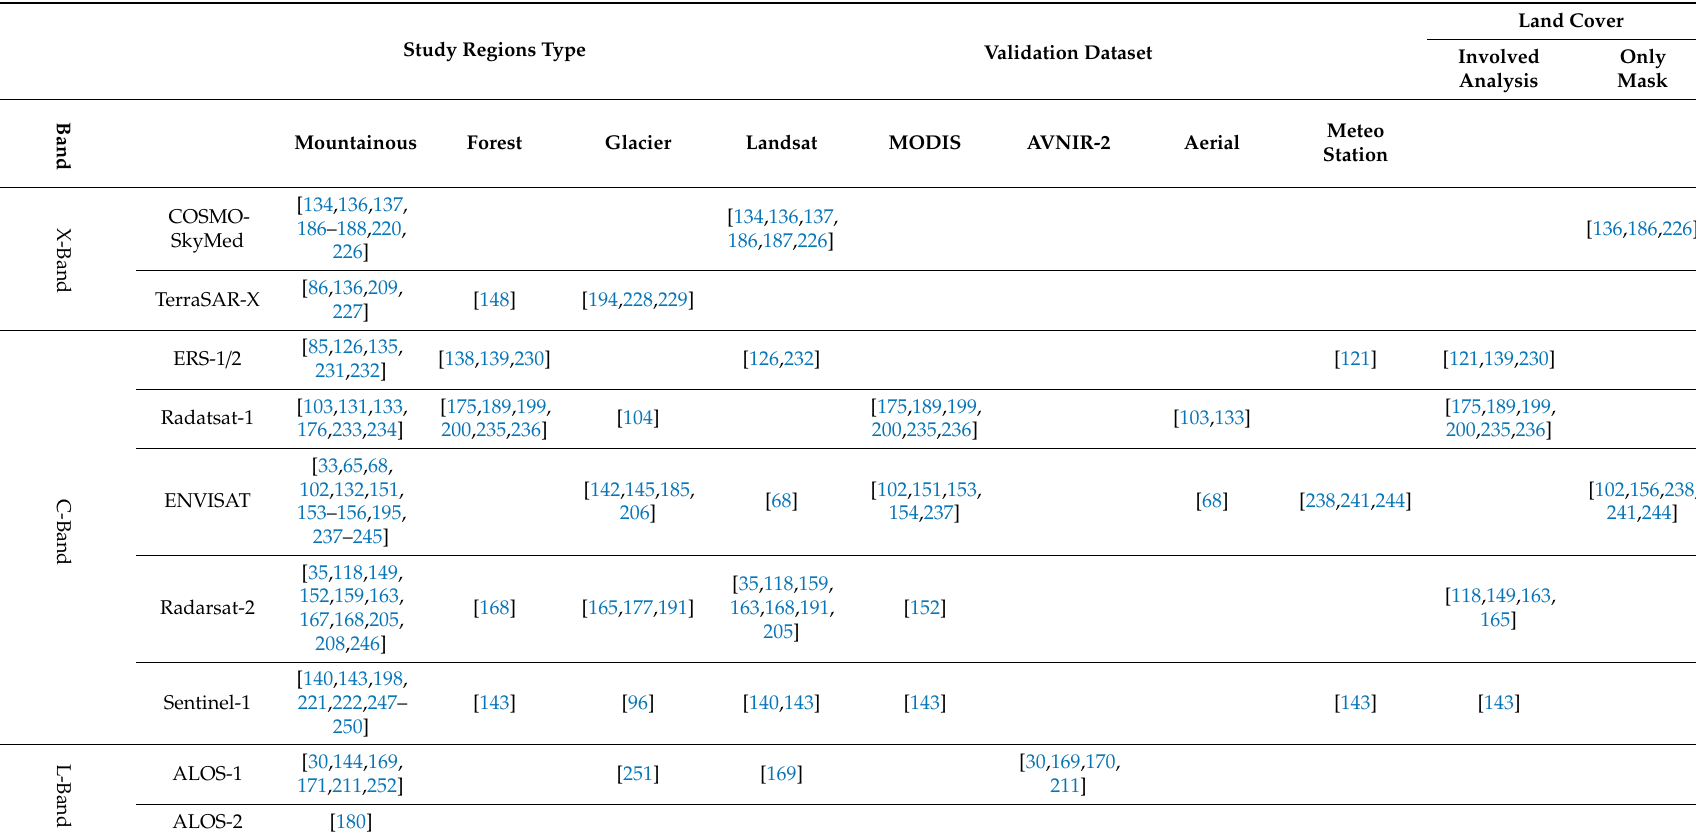
Table A2. Summary of included studies’ SCE monitoring strategy (studying region type, validation data and usage of land cover information).